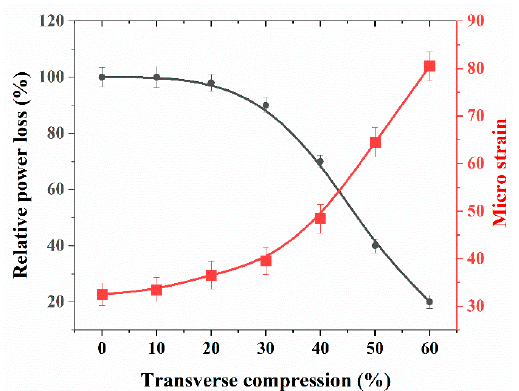
Figure 6. Relative power loss and microstrain plotted as a function of spinal cord transverse com- pression for static loading.